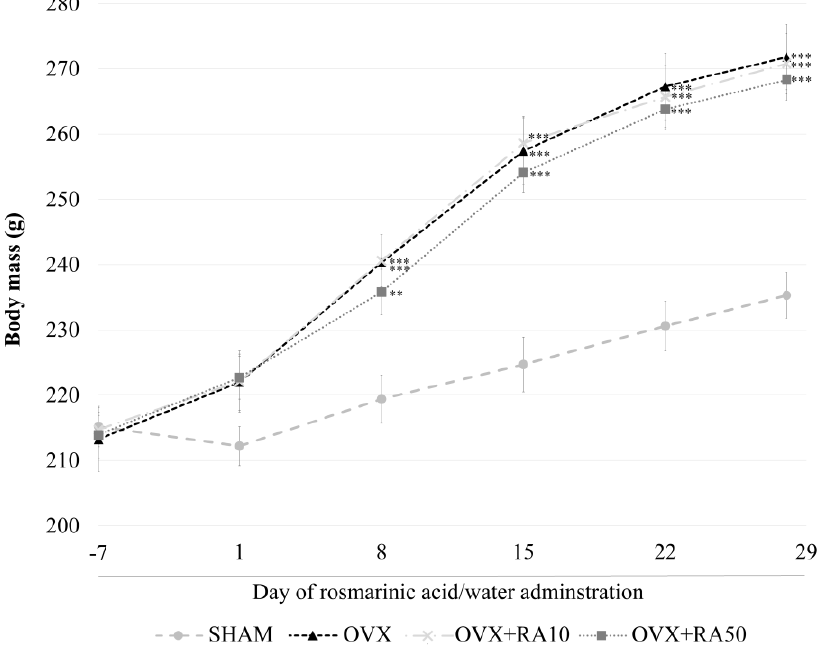
Figure 1. Effect of rosmarinic acid on the body mass in ovariectomized rats. Rosmarinic acid at doses of 10 mg/kg (OVX + RA10) and 50 mg/kg (OVX + RA50) was administered orally to ovariectomized rats, once daily for 28 days. SHAM: sham-operated control rats; OVX: ovariectomized control rats. The final measurements of the body mass were made before the last rosmarinic acid or water administration (28th day). Results are presented as the mean ± SEM. One-way ANOVA followed by Fisher’s LSD test were used for evaluation of the significance of the results. ** p < 0.01, *** p < 0.001: significantly different from the SHAM control rats.